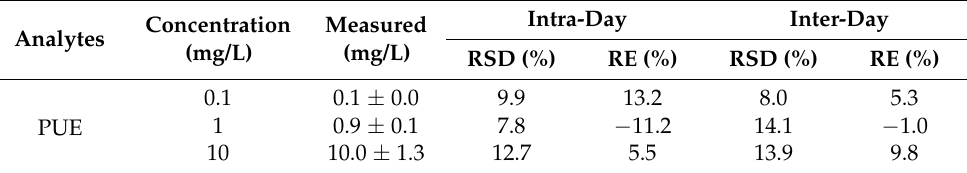
Table 1. Intra- and inter-day precision and accuracy at different concentrations. ( n =